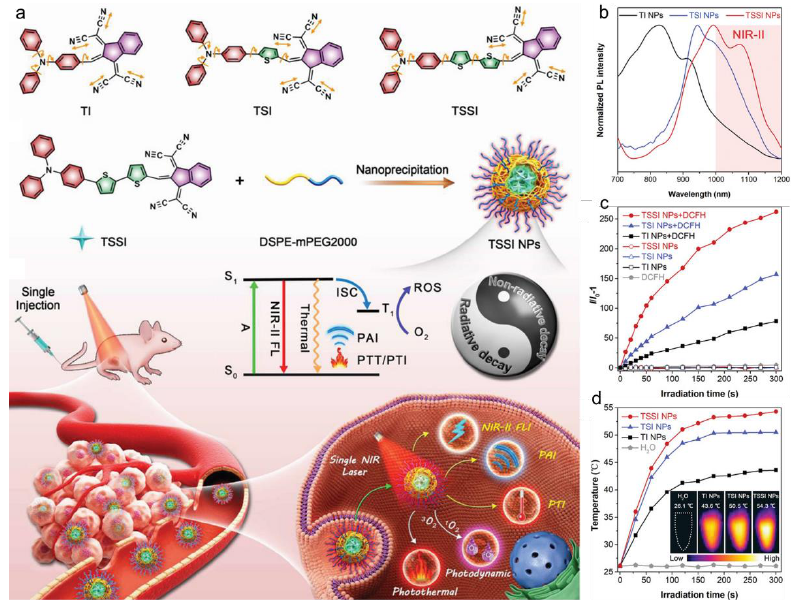
Figure 3. ( a ) Schematic illustration of the chemical structures, NPs fabrication, and biomedical applications. ( b ) PL spectra, ( c ) ROS generation using DCFH-DA, and ( d ) photothermal curves of TI, TSI, and TSSI NPs under the irradiation of 660 nm laser (Reprinted with permission from Ref. [93]. Copyright 2020, WILEY-VCH Verlag GmbH & Co. KGaA, Weinheim, Germany). Zhang et al., synthesized a series of AIEgens with distorted tetraphenylethylene (TPE) and diphenylamine (DPA) as donors and molecular rotors, electron-rich carbazole as a conjugated bridge, and three different positively charged fractions (pyridine, quino- line, and acridine) as acceptors, affording three derivatives: TPEDCPy, TPEDCQu, and TPEDCAc [94]. By increasing the electron-withdrawing capacity of the A units from pyr- idine to acridine, the intramolecular charge-transfer effect was significantly enhanced and the intramolecular motion was more intense, which led to red-shifted absorption in the NIR-I region and strong emission in the NIR-II region (Figure 4). TPEDCPy, TPEDCQu, and TPEDCAc showed absorptions in the range of 460 – 580 nm, corresponding to maxi- mum emissions of 660 nm, 730 nm, and 980 nm with a fluorescence quantum yield (QY) of 2.9%, 2.6%, and 0.4%, respectively. The ROS generation capacity was also evaluated by using 2 ’ ,7 ’ -dichlorofluorescein diacetate (DCFH-DA) as the indicator, which decreased in the trend of TPEDCPy < TPEDCQu < TPEDCAc. Further verification of the photothermal behavior of the three molecules showed that TPEDCPy and TPEDCQu almost had no temperature increase, while TPEDCAc displayed good photothermal effect with a PCE of 44.1% as the large acridine part provided more space for backbone deformation and rotor torsion. Noteworthy, the amphipathic TPEDCAc could easily self-assemble into homoge- neously distributed nanoaggregates with good stability. Based on the bright fluorescence emission in the NIR-II region of TPEDCAc aggregates, the high photodynamic/photother- mal efficiency, and the excellent tumor-killing effect at the cellular level, the tumor diag- nostic and therapeutic efficacy in vivo was evaluated. The fluorescence signals in the NIR- II region started to appear in the tumor site at 0.5 h post injection, which became strongest at about 6 h and the tumor could still be clearly visualized at 48 h. Moreover, the concur- rent PA imaging in vivo helped to provide more detailed information about the tumor. Under 660 nm laser irradiation, the temperature of the tumor site increased significantly,